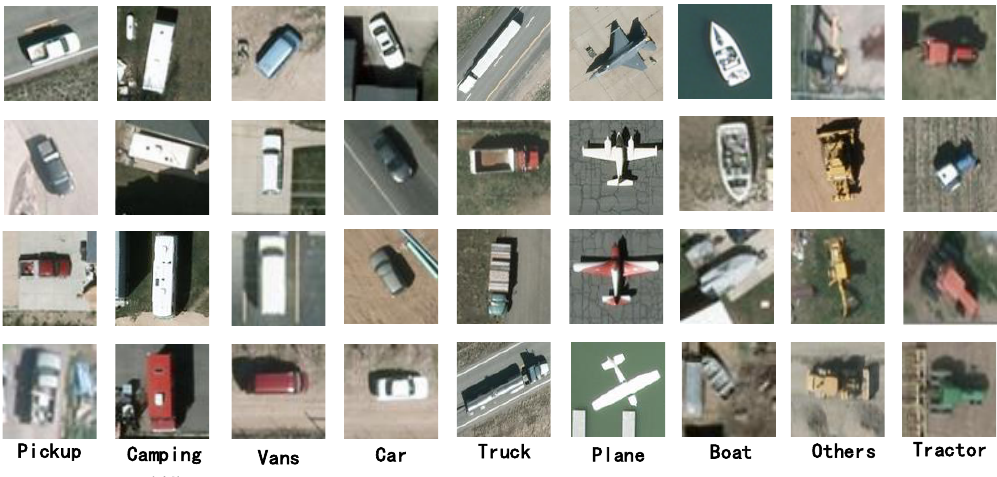
Figure 2. Examples of di ff erent vehicle types in VEDAI dataset.